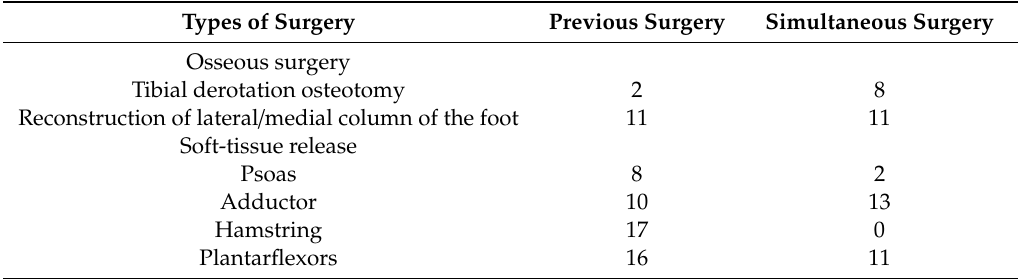
Table 1. The lists of previous and simultaneous surgeries. Types of